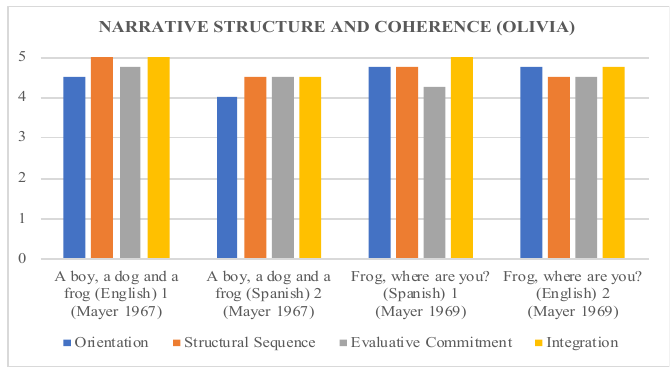
Figure 4. Olivia’s scores for the narrative structure and coherence dimension.